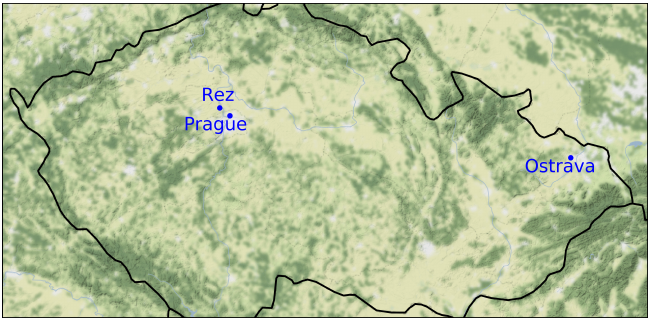
Figure 1. Location of computing centers federated under praguelcg2